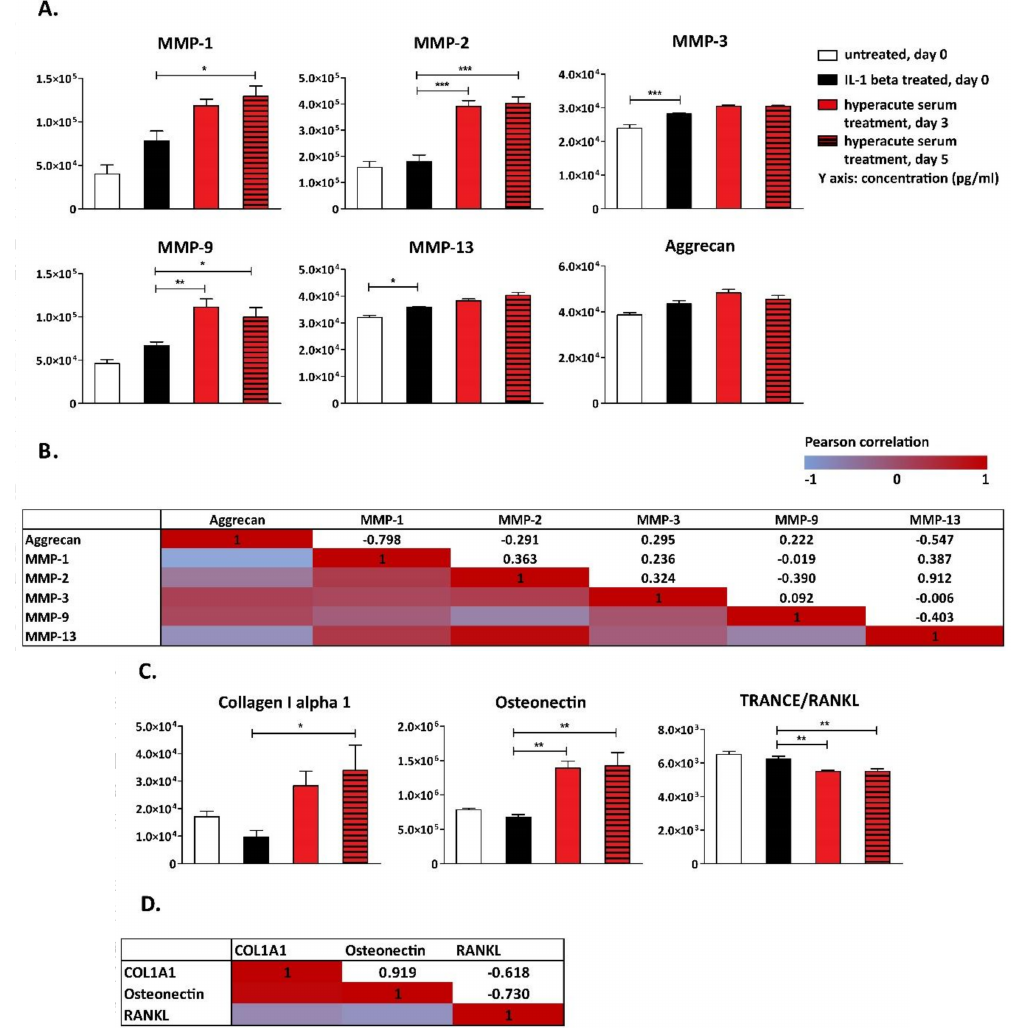
Figure 8. Biomarkers of tissue remodeling detected in tissue culture supernatant. IL-1 β a ff ected only MMP-3 and -13, while the concentrations of MMP-1, -2, and -9 increased significantly in response to hyperacute serum treatment ( A ). The significance level was p < 0.05, where * means that the p -value was between 0.05 and 0.01, ** means that the p -value was between 0.01 and 0.001, and *** means that the p -value was lower than 0.001, n = 12. The correlations of cytokine changes are presented in heatmap tables. A very strong correlation was found between MMP-2 and MMP-13, while reverse strong correlations were found between aggrecan and MMP-1 and MMP-13 ( B ). Osteonectin was also significantly elevated in response to hyperacute serum treatment. Similar changes were observed in collagen type I alpha I secretion, while receptor activator of nuclear factor kappa-B ligand (RANKL) continuously decreased in response to the hyperacute serum treatment ( C ). The significance level was p < 0.05, where * means that the p -value was between 0.05 and 0.01, ** means that p -value was between 0.01 and 0.001, and *** means that the p -value was lower than 0.001, n = 12. The correlation of cytokine changes between osteonectin and collagen 1 alpha 1 (COL1A1) was very strong, while reverse strong correlations were found between osteonectin, COL1A1, and RANKL, n = 12 ( D